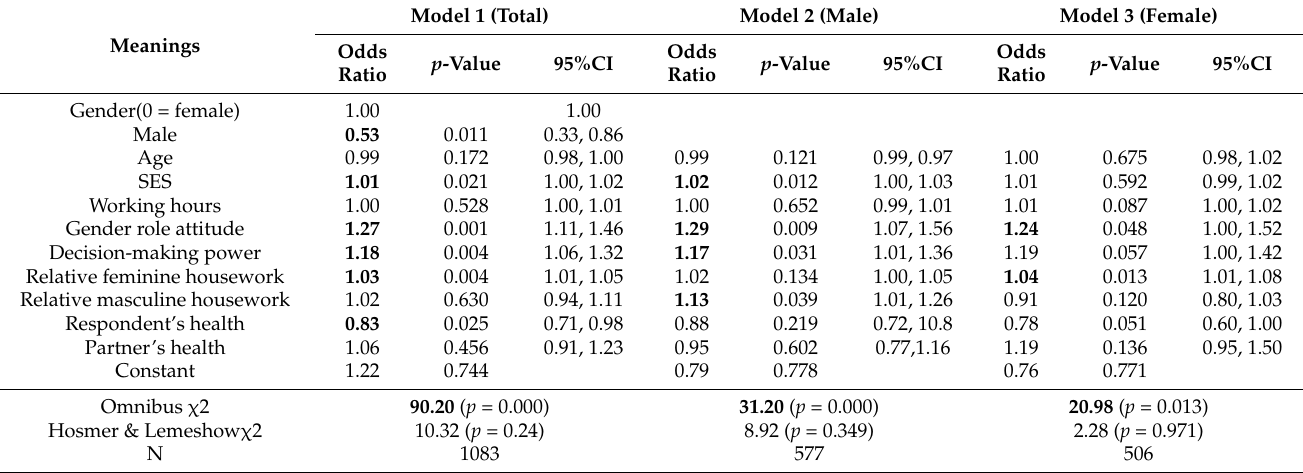
Table 2. Binary logistic regression predicting two types of housework-related